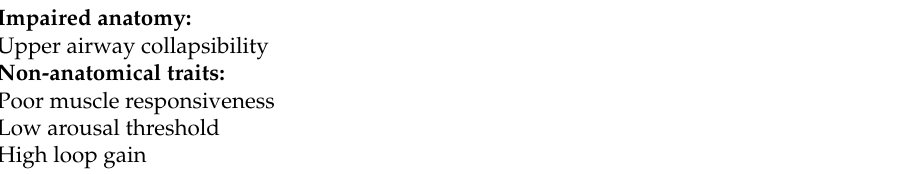
Table 1. Pathophysiological obstructive sleep apnea (OSA) traits. Impaired